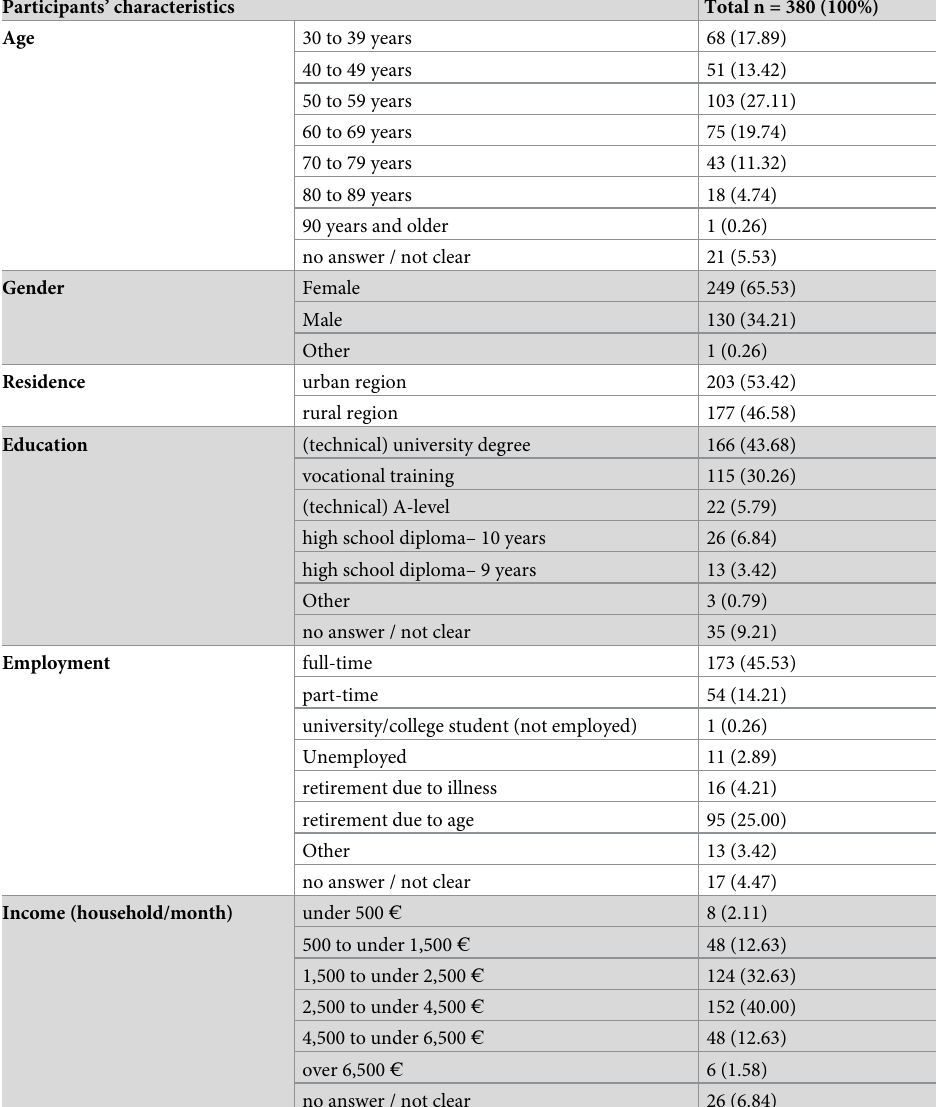
Table 3. Participants‘